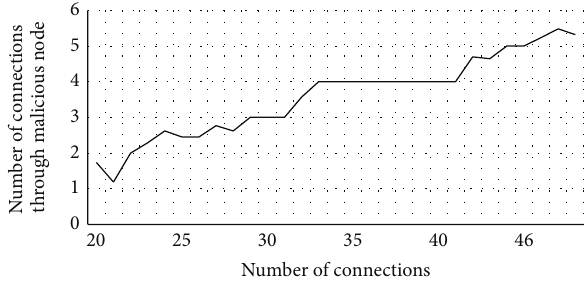
Figure 4: Connections with 5% of malicious